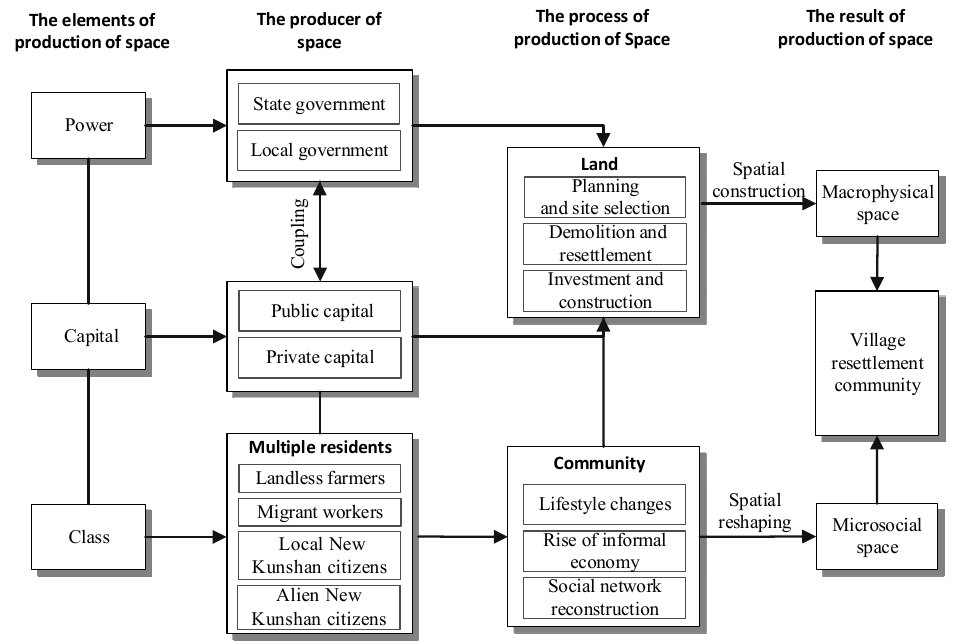
Figure 1. Conceptual framework.